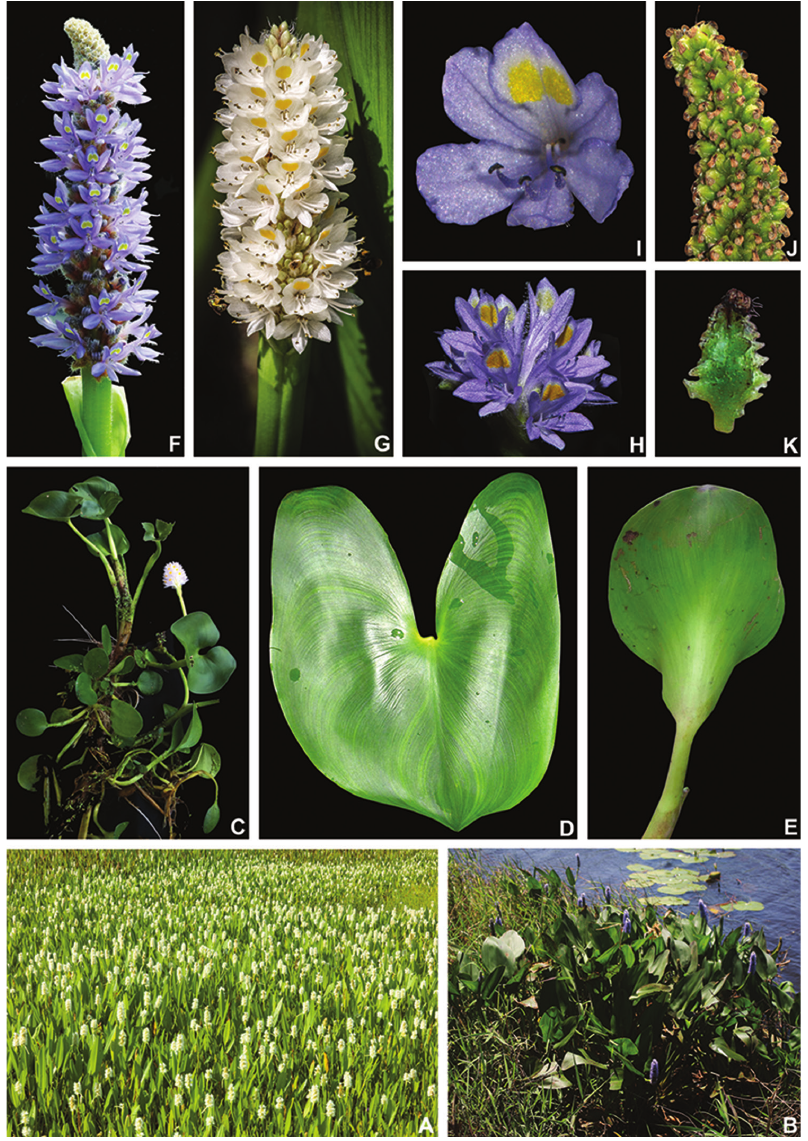
Figure 9. Pontederia L. subg. Pontederia . A–C habit: A dense population of P. parviflora Alexander B population of P. ovalis Mart. ex Schult. & Schult.f. C habit of P. rotundifolia L.f. D–E petiolate leaves: D blade of P. rotundifolia E blade of P. parviflora F–H inflorescences: F inflorescence of P. cordata L., showing flowers with two yellow nectar guides in the posterior perianth lobes G inflorescence of P. parvi- flora , showing flowers with a sole yellow nectar guide in the posterior perianth lobes H inflorescence of P. rotudifolia , showing a lilac-flowered form I oblique view of a flower of P. ovalis J–K fruits: J detail of the apex of the infructescence of P. ovalis , showing the anthocarp with sinuate ridges K detail of an achene of P. cordata , showing the toothed ridges. A by C. Willig & L. Nusbaumer B, I, J by M.O.O. Pellegrini C by L.O.A. Teixeira, D, H by R. Aguilar E by M.R. Engels F by Ashitaka-f Studio G by M.V. Lameiras and K by A.